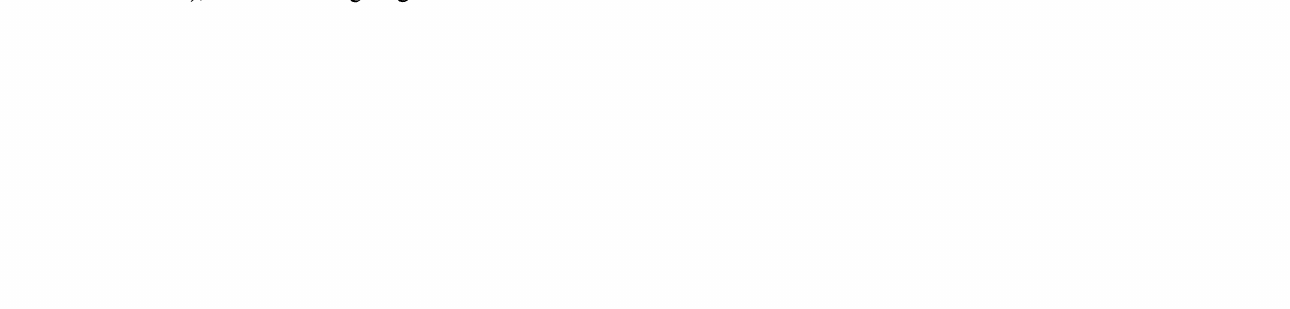
FIGURE 3 Chaotic dynamics in the unit cube in absence of attractors; 25,000 iterations. See text for parameter specifica-